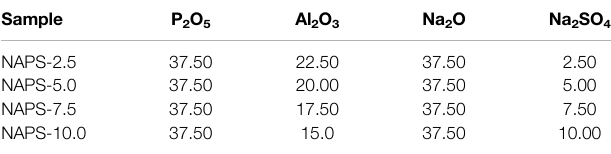
TABLE 1 | Chemical composition of glasses